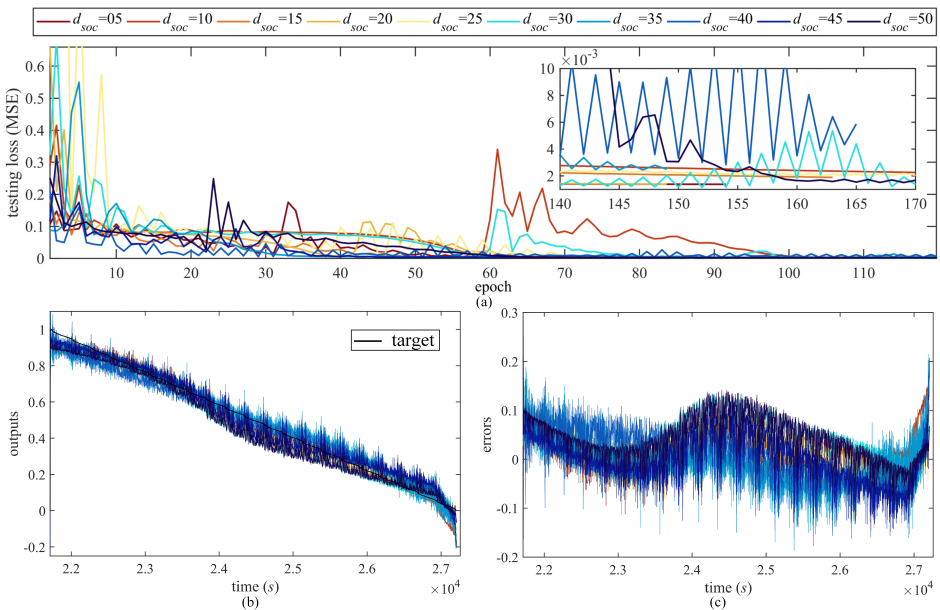
Figure 12. Sensitivity of the ratio d soc between OCV and SOC in battery FOM for fractional-order PDE constraint, d soc = 5:5:50, ( a ) testing loss, ( b ) testing outputs, and ( c ) testing